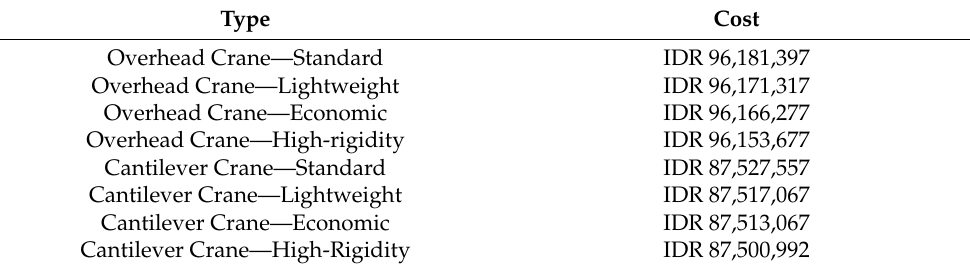
Table 8. Capital Cost for All Types of Overhead and Cantilever Crane